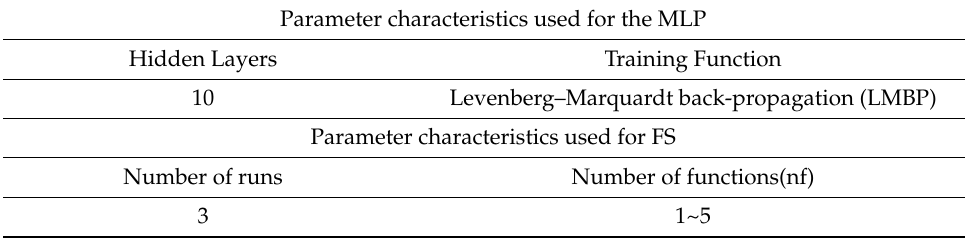
Table 8. Parameter characteristics used for MLP and